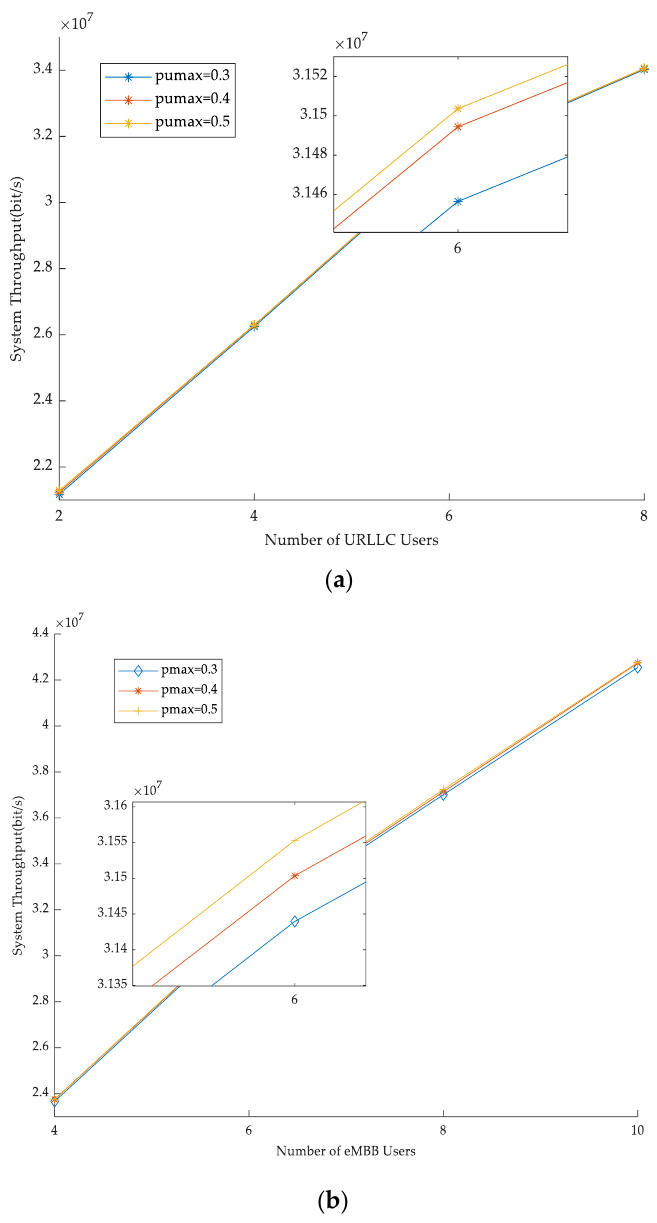
Figure 4. Maximum allocated power of users versus throughput. ( a ) Maximum power allocated by URLLC users versus throughput. ( b ) Maximum power allocated by eMBB users versus throughput.